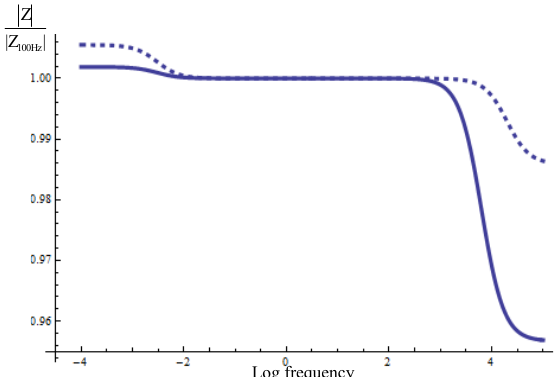
Fig. 2.B: Spectra of Impedance magnitude relative to the value at 100 Hz for suspensions of large cells ( R 1 ~ 0.5 mm), Δϕ 0 = -150 mV; σ 2 = 10 -6 S/m (solid line); σ 2 = 10 -5 S/m (dashed)